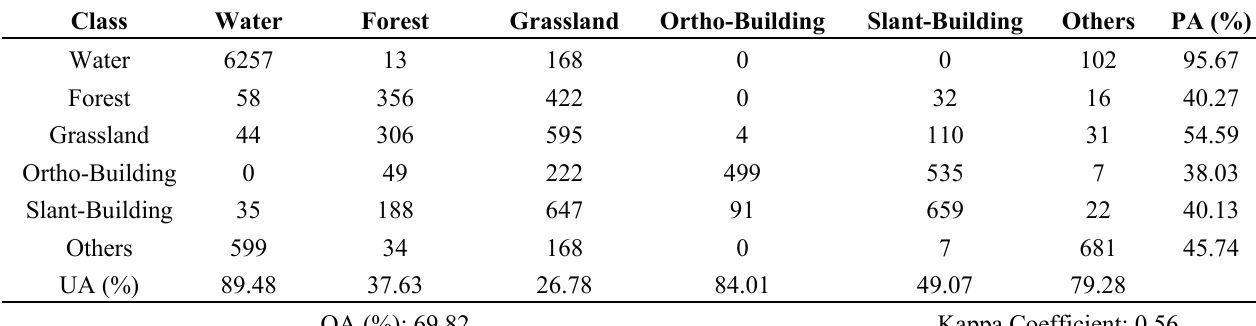
Table 2. Confusion matrix of Wishart supervised classification method. (PA = producer’s accuracy, UA =user’s accuracy, OA =overall